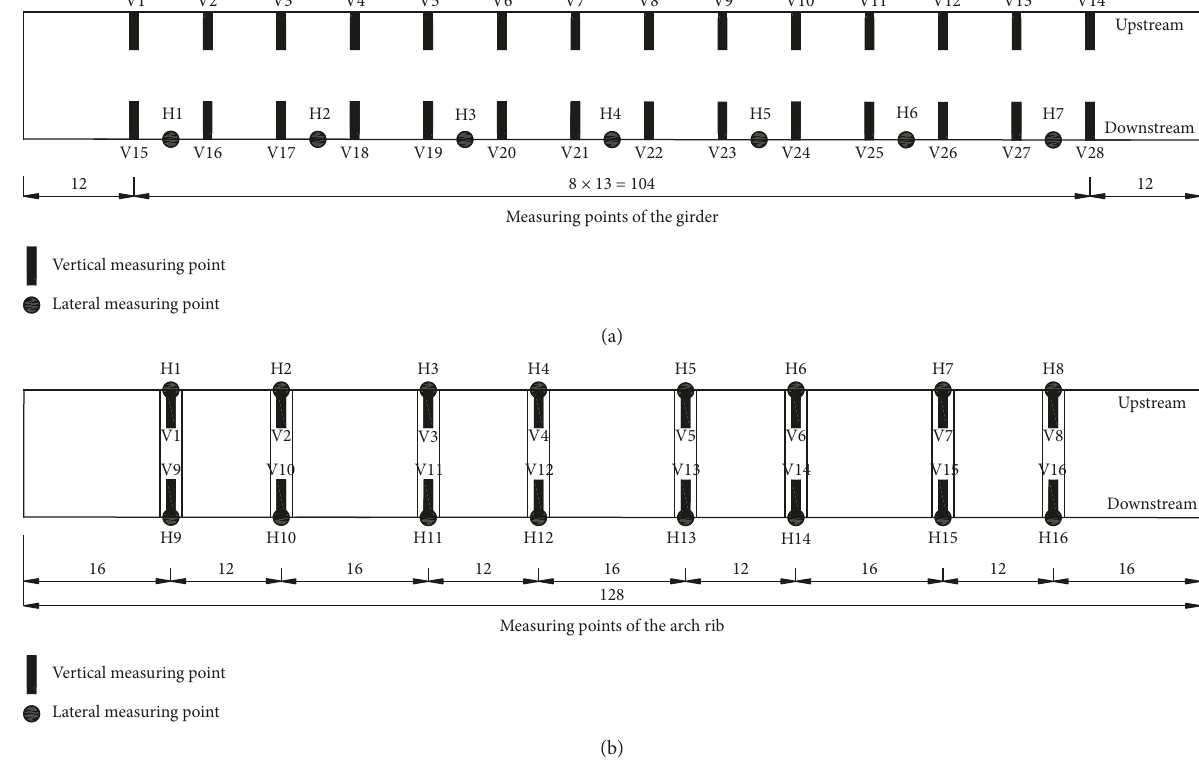
Figure 6: The arrangement of the sensors (unit: